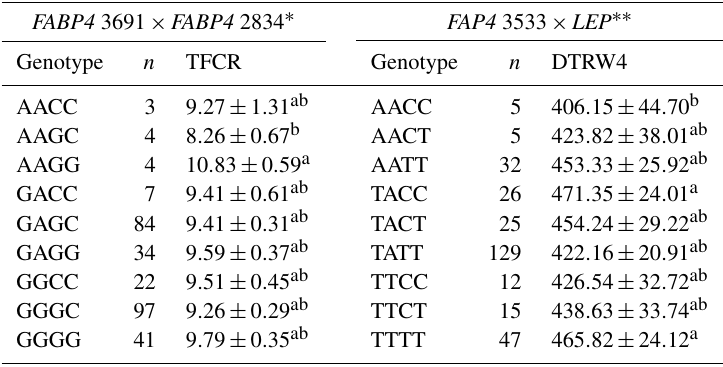
Table 10. Least-square means and standard errors for the significant associations of genotypic interactions ( FABP4 3691 × FABP4 2834 and FAP4 3533 × LEP ) with related traits ( n =